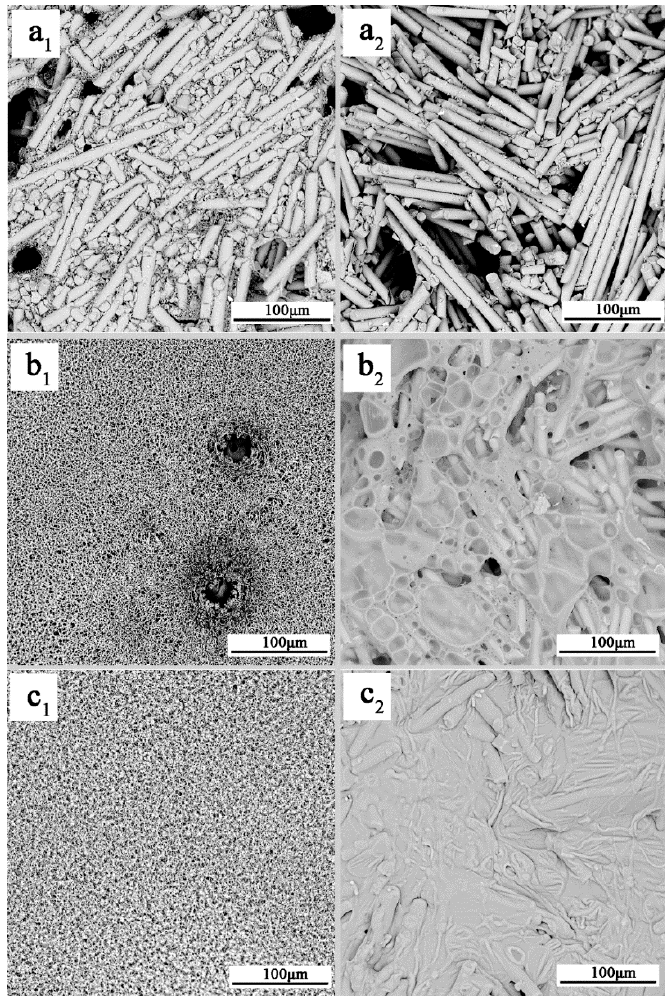
Figure 6. SEM photos of the top-surface ( a1 , b1 , c1 ) and middle-tier ( a2 , b2 , c2 ) residues from the cone calorimeter: ( a ) 5.1%PI/PA66, ( b ) 17.0%MPP/PA66, ( c ) 11.9%MPP/5.1%PI/PA66.